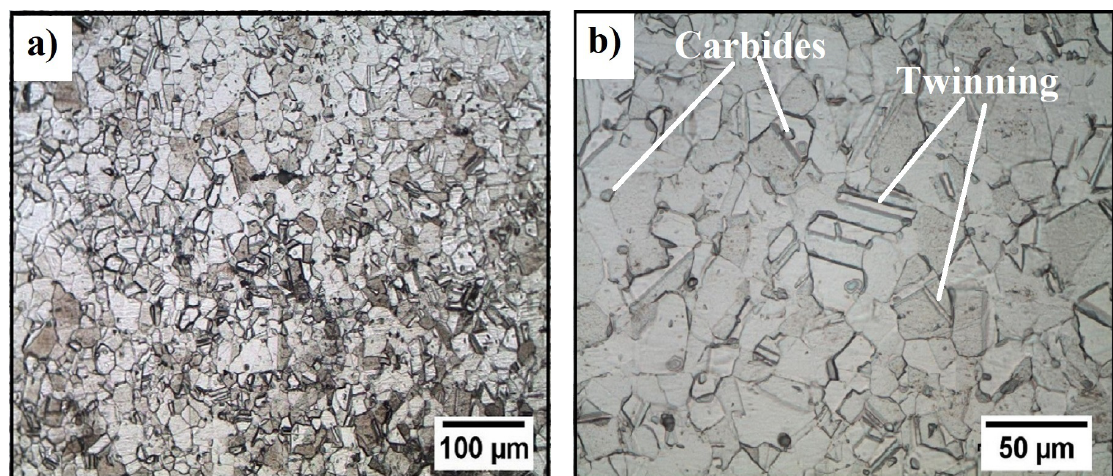
Figure 12: Optical microstructure of base material in 980 ∘ C solution treated condition: a) lower magnification (200X) b) higher magnifica- tion